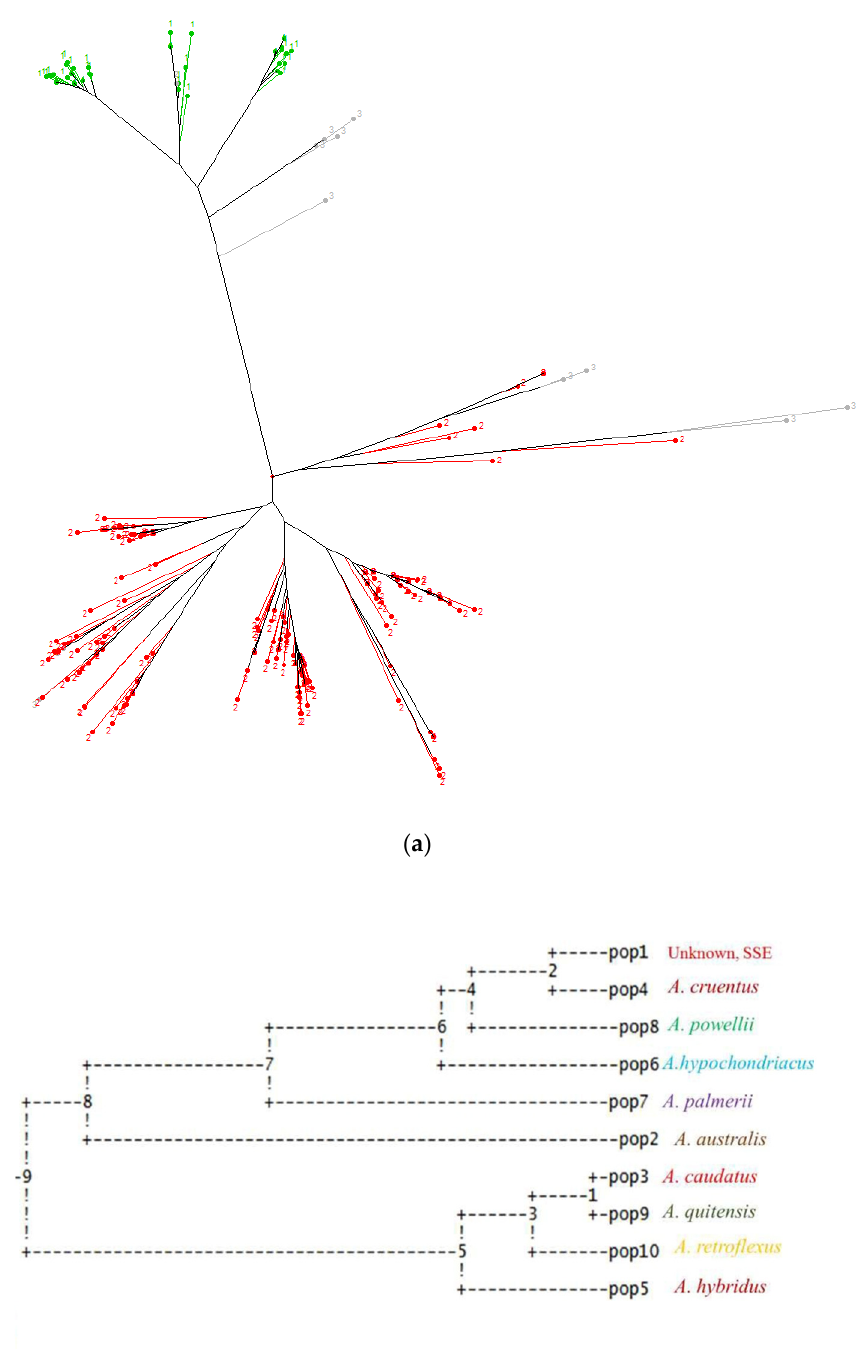
Figure 2. Relationships between accessions of Amaranths by ( a ) clustering with an UPGMA neighbor joining tree showing three major subgroups (subpopulation 1 shown in green colored dots, consisting of A. caudatus grain amaranths and A. quitensis wild relative accessions; subpopulation 2 in red colored dots consisting of A. cruentus and A. hypochondriacus grain amaranths; subpopulation 3 in gray dots and lines consisting of other species and weedy relatives) and ( b ) phylogenetic analysis of the USDA and SSE cultivars form nine species based on Nei [45] with numbers representing steps in species differentiation.